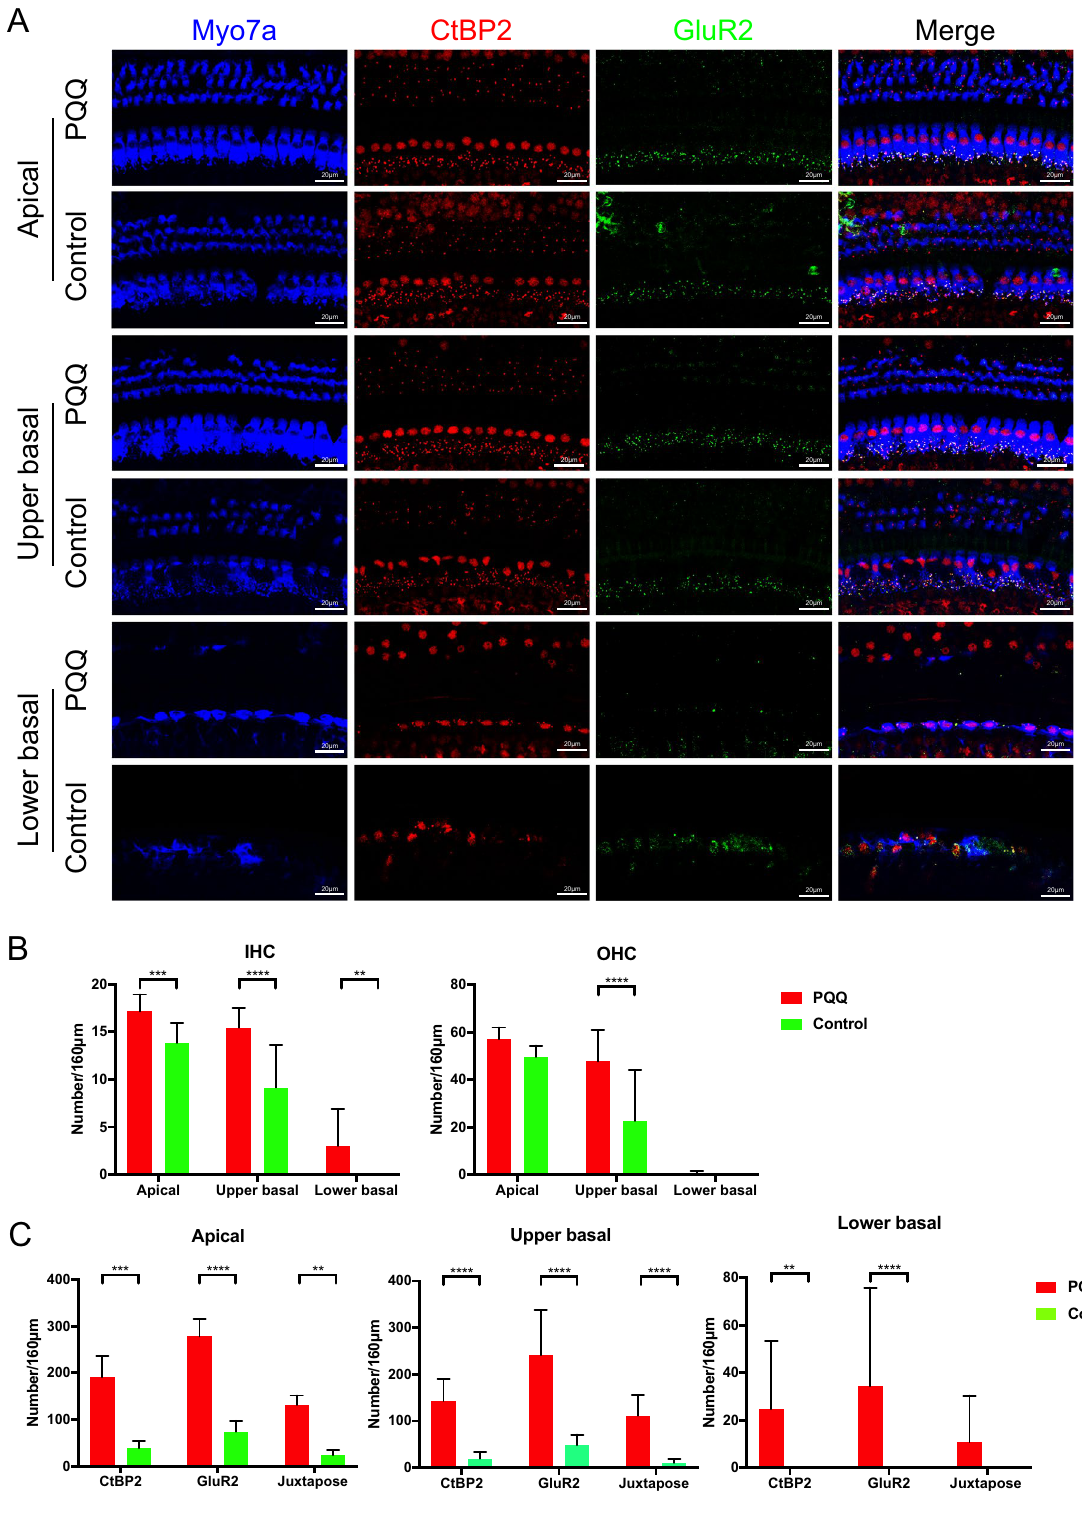
Figure 6. Evaluation of the hair cells and ribbon synapses in the age-related hearing loss model ( A ) Confocal images of the ribbon synapses of the IHCs of the cochlea in ARHL. The pre-synaptic marker (CtBP2, red), the post-synaptic marker (GluR2, green) and the hair cell marker (Myo7A, blue) are immunolabeled. ( B ) The number of IHCs and OHCs of the sensory epithelium per 160 µm. ( C ) The number of the ribbon synapses of the IHCs per 160 µm of sensory epithelium. Juxtapose is the number of juxtaposed pre-synaptic marker (CtBP2) and post-synaptic marker (GluR2). ** p < 0.01, *** p < 0.001, **** p < 0.0001. (Control group ( n = 10) and PQQ group ( n =